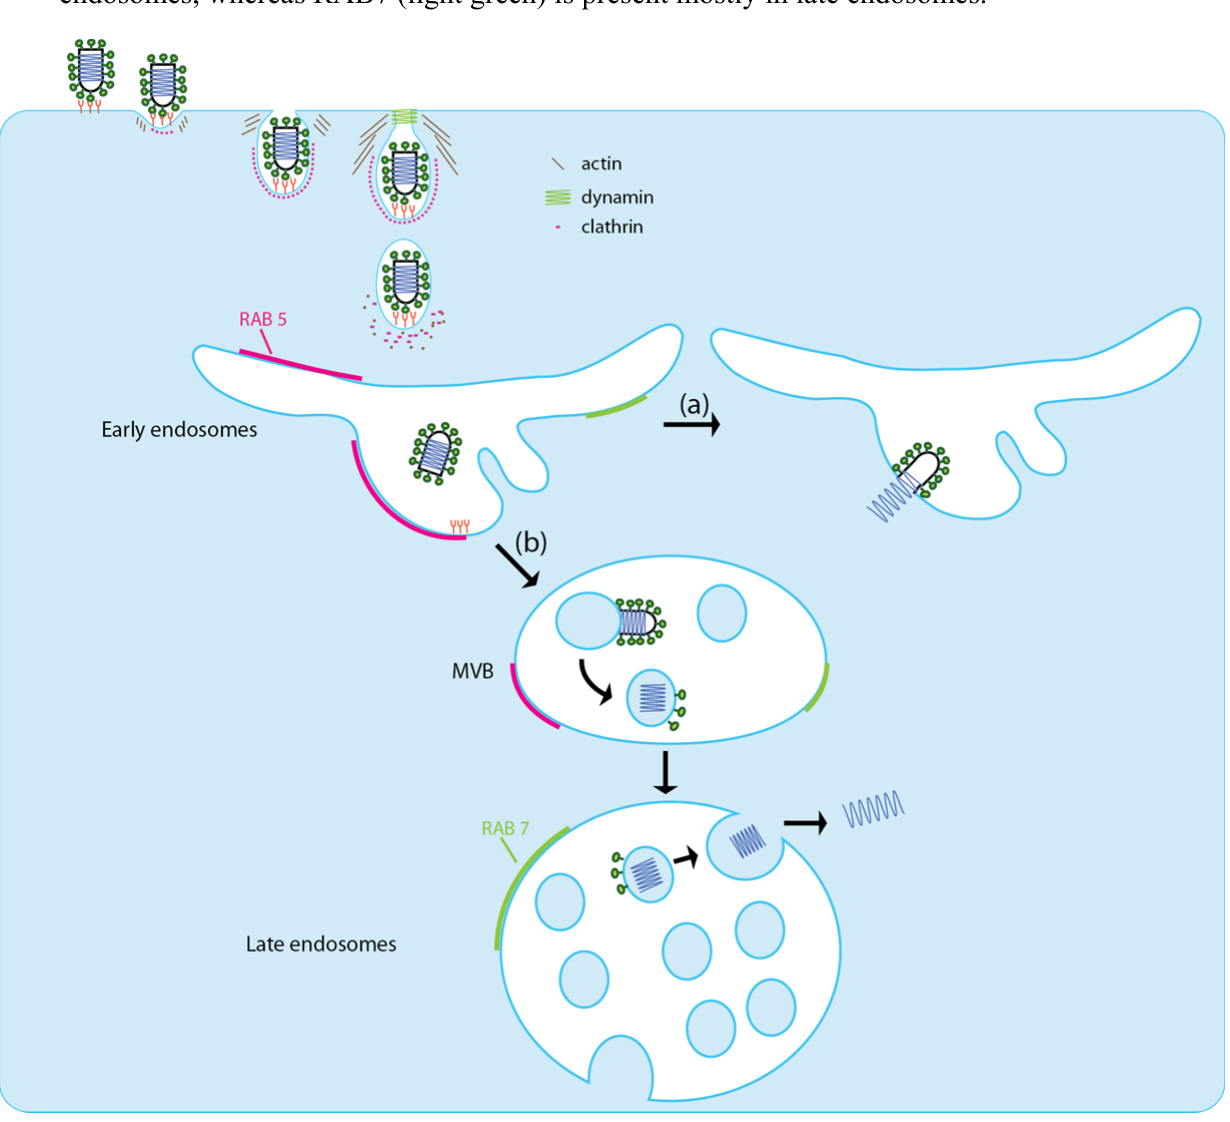
Figure 5. The two proposed pathways for VSV entry into the host cell. VSV binds to the host cell via an interaction with one or several unknown receptors. The VSV particles are then endocytosed in a clathrin-based, dynamin-2-dependent manner. The endocytosis vesicle is partially coated with clathrin and requires actin polymerization for efficient viral entry. Pathway ( a ): fusion occurs rapidly in early endosome and leads to the release of the nucleocapsid into the cytoplasm. Pathway ( b ): VSV fuses first with an internal vesicle inside multivesicular bodies. The nucleocapsid is then released in an internal vesicle. In the late endosome, these vesicles deliver the nucleocapsid to the cytoplasm through a back-fusion mechanism. Small GTPase RAB5 (pink) is mainly present on early endosomes, whereas RAB7 (light green) is present mostly in late